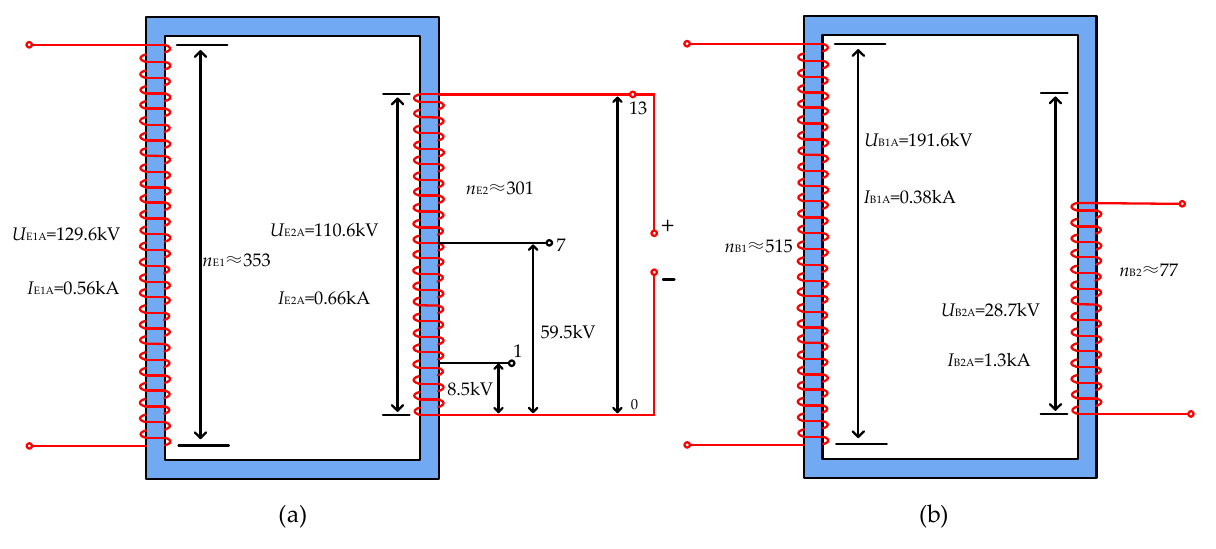
Figure 11. Parameters of the excitation transformer and series transformer. ( a ) Series transformer, ( b ) Excitation transformer.